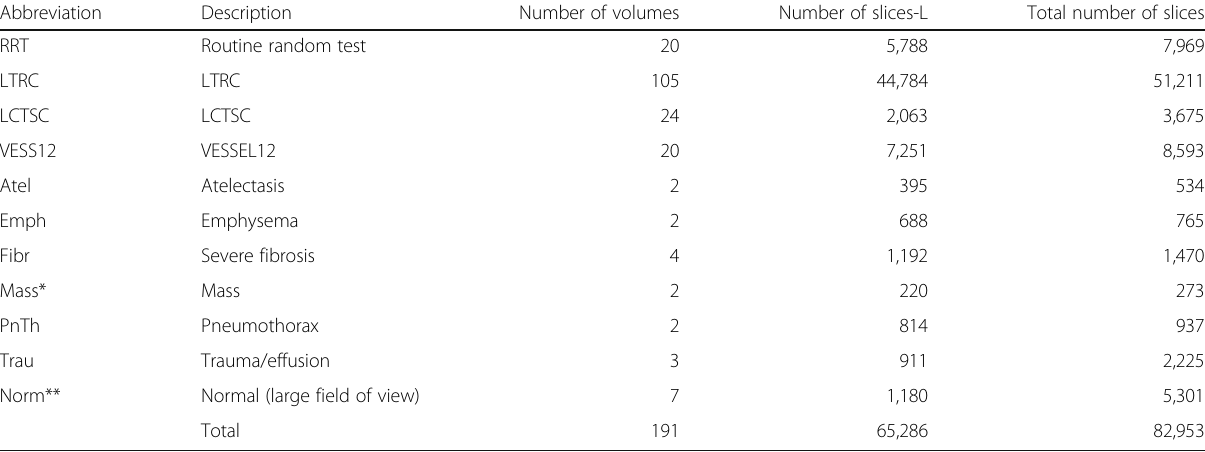
Table 2 Test datasets used to evaluate the performance of lung segmentation algorithms